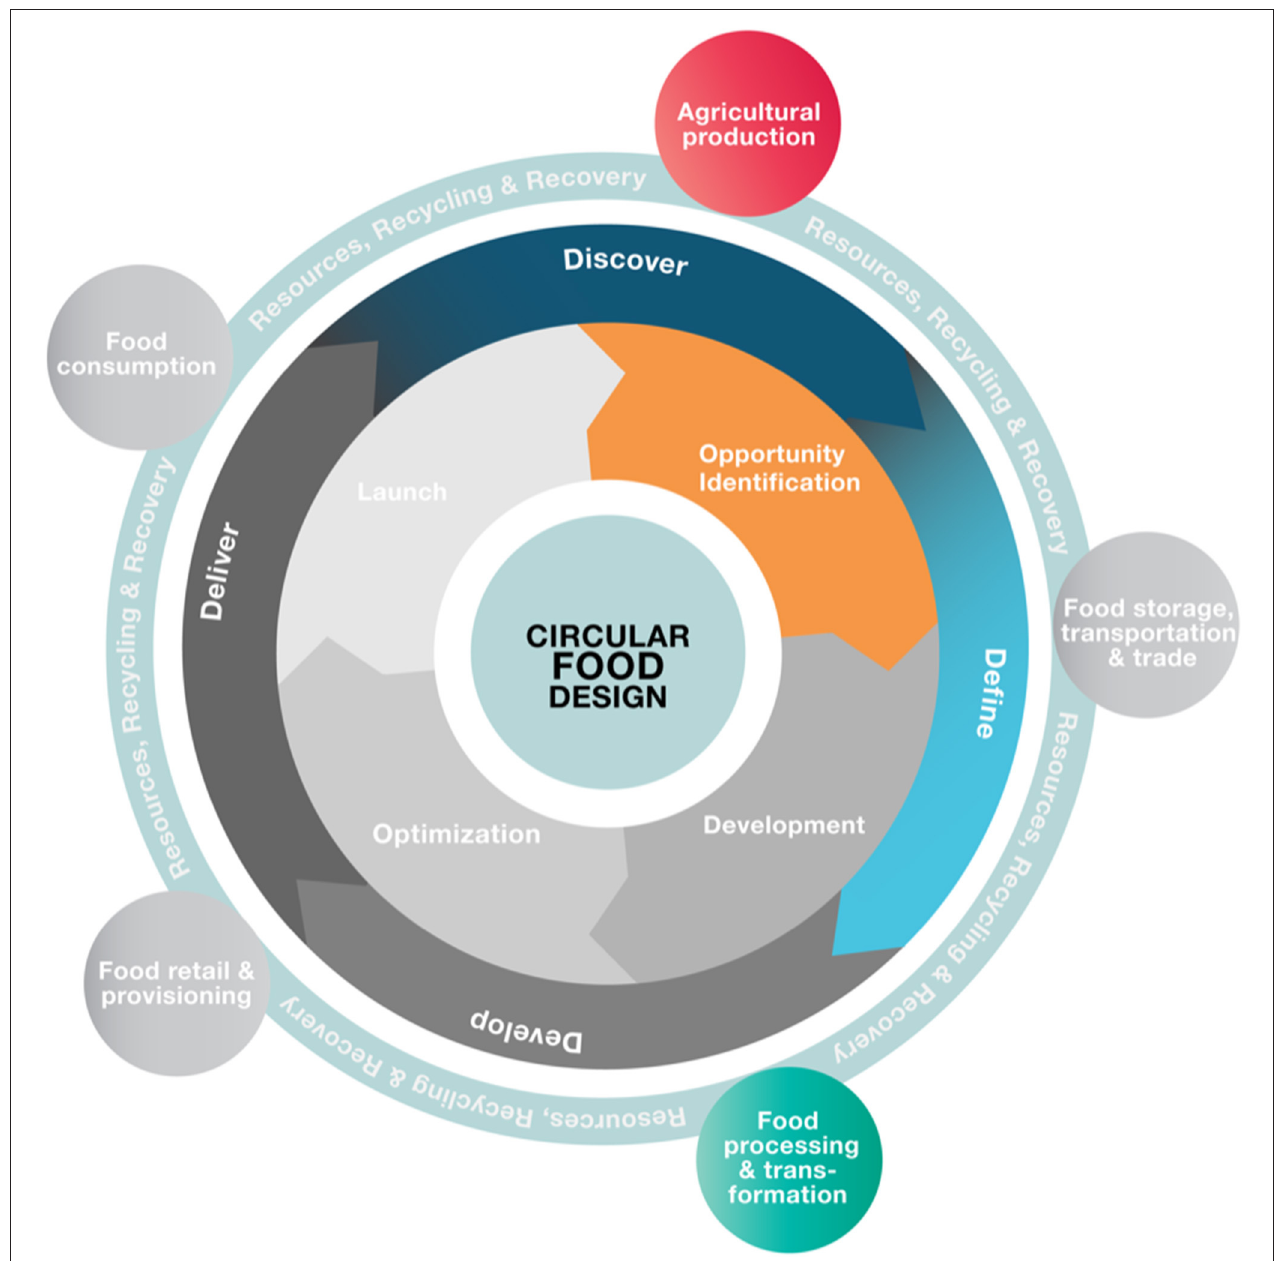
FIGURE 5 | Circular food design, application exploring